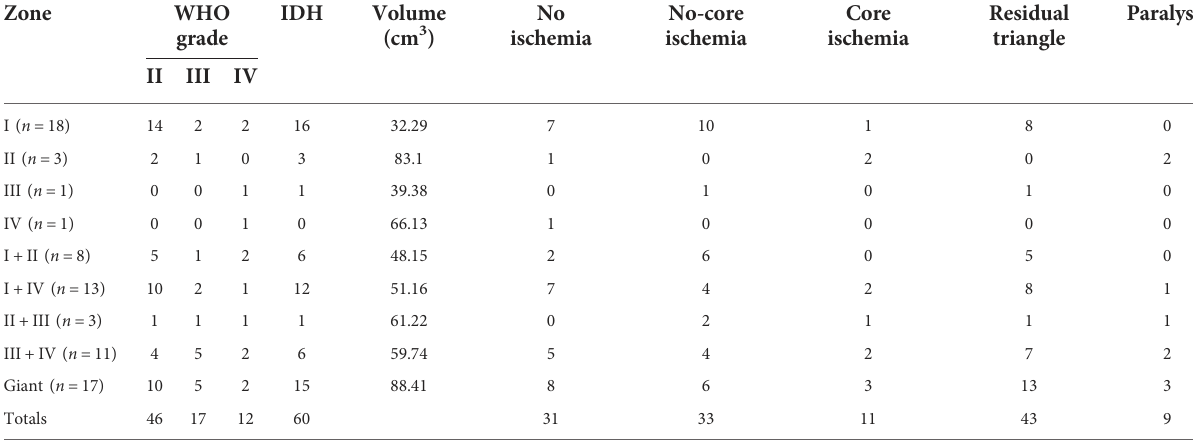
TABLE 2 Summary of resected insular gliomas by